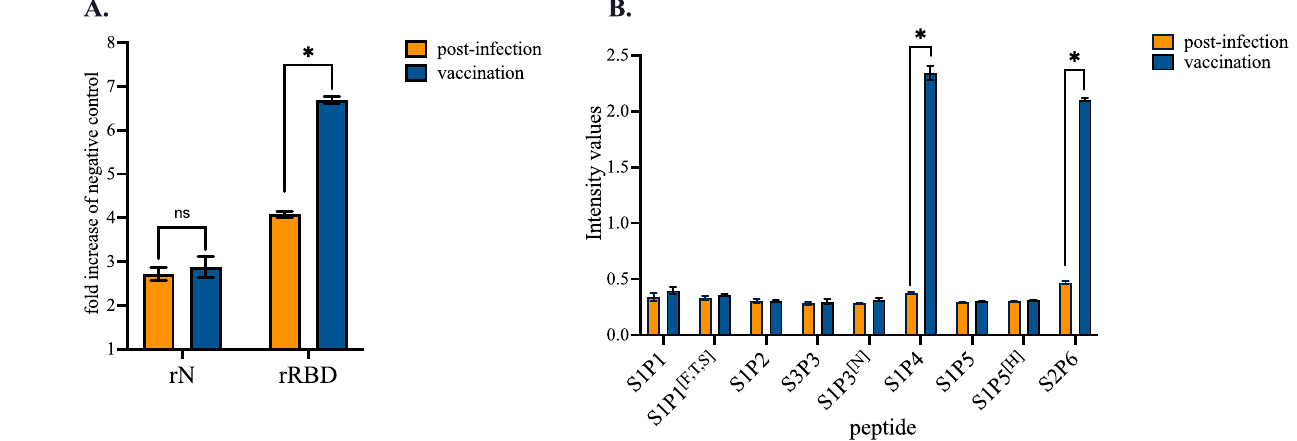
Figure 4. Antigenic reactivity of synthetic peptides with immune sera from a COVID-19 immune subject who received comirnaty vaccine. Serum samples from a COVID-19 patient were collected few weeks after recovery of SARS-CoV-2 infection (post-infection) and then two weeks after the injection of a single dose of comirnaty vaccine (vaccination). Vaccine administration was performed three months after COVID-19 recovery. In ( A ), serum samples at dilution 1:100 were assayed for the detection of antibodies against SARS-CoV-2 N and spike proteins by indirect ELISA using recombinant rN and rRBD proteins for antigen-based antibody capture. A pool of serum samples from infection-naïve individuals (Table S3) served as negative control serum. The intensity values of serum samples were measured at O.D. 450 nm and their immune reactivity was estimated as a fold increase of intensity values obtained with negative control serum. The results are the mean (± SEM) of three replicates. Statistically significant comparisons are shown as * p < 10 –4 (ns: non-statistically significant, p > 0.05). In ( B ), serum samples at dilution 1:50 were assayed for the detection of specific antibodies through peptide-based ELISA. The intensity values of serum samples were measured at O.D. 450 nm. The results are the mean (± SEM) of three replicates. Paired t tests on experimental points between post-infection and vaccination immune were performed and statistically significant comparisons are shown as * p < 10 –4 . Differences